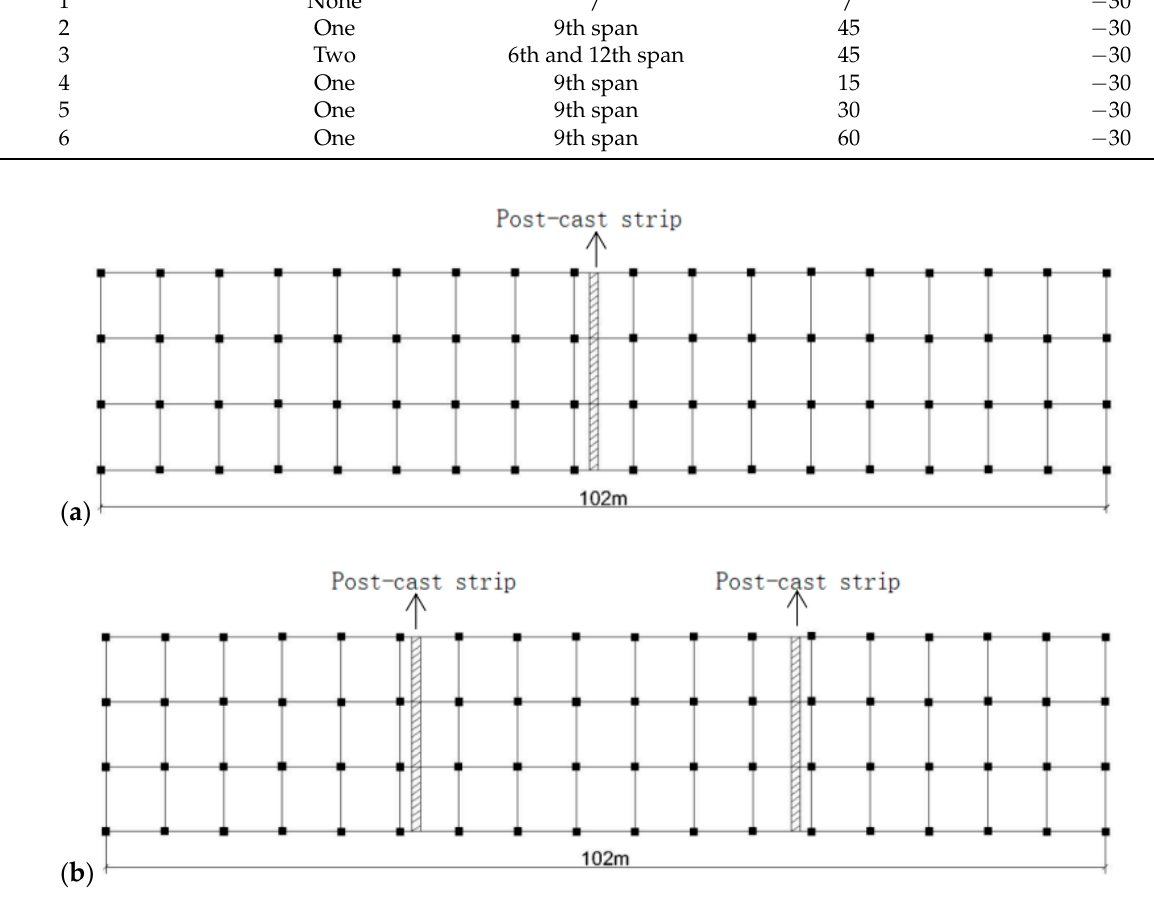
Figure 4. Location of post-cast strips: ( a ) One post-cast strip; ( b ) Two post-cast strips.